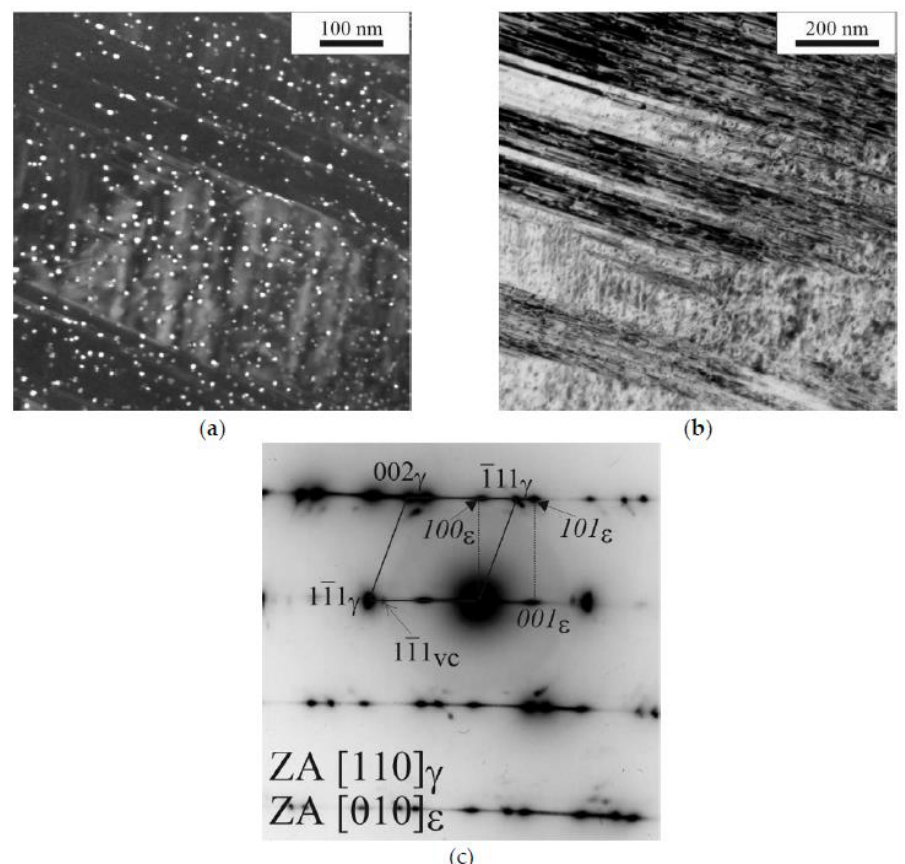
for example, at 720 ◦ C [23]. Figure 1a,b shows the structure of the 0.4C-18Mn-2Si-2V steel after destabilizing aging with the precipitation of enlarged VC carbides ((a) with an average size of 9 nm and a number density of 3 × 10 16 cm − 3 ) and after the martensitic the martensitic γ → ε transformation with the formation of (b) 74 % ε -martensite in the γ → ε transformation with the formation of (b) 74% ε -martensite in the process of a small process of a small (4.7 %) cold deformation. (4.7%) cold deformation.